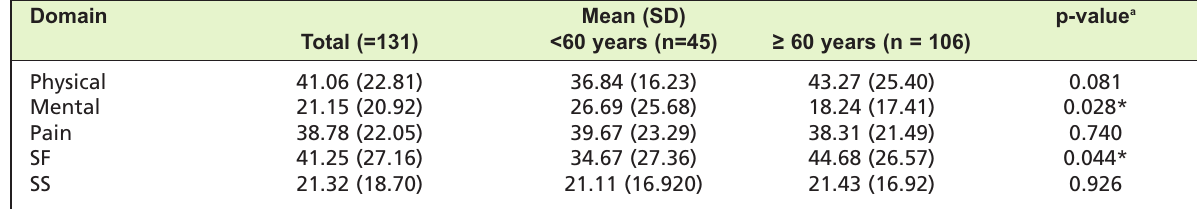
HRQOL according to age group by using OAKHQOL questionnaire (n = 131) Table VI: